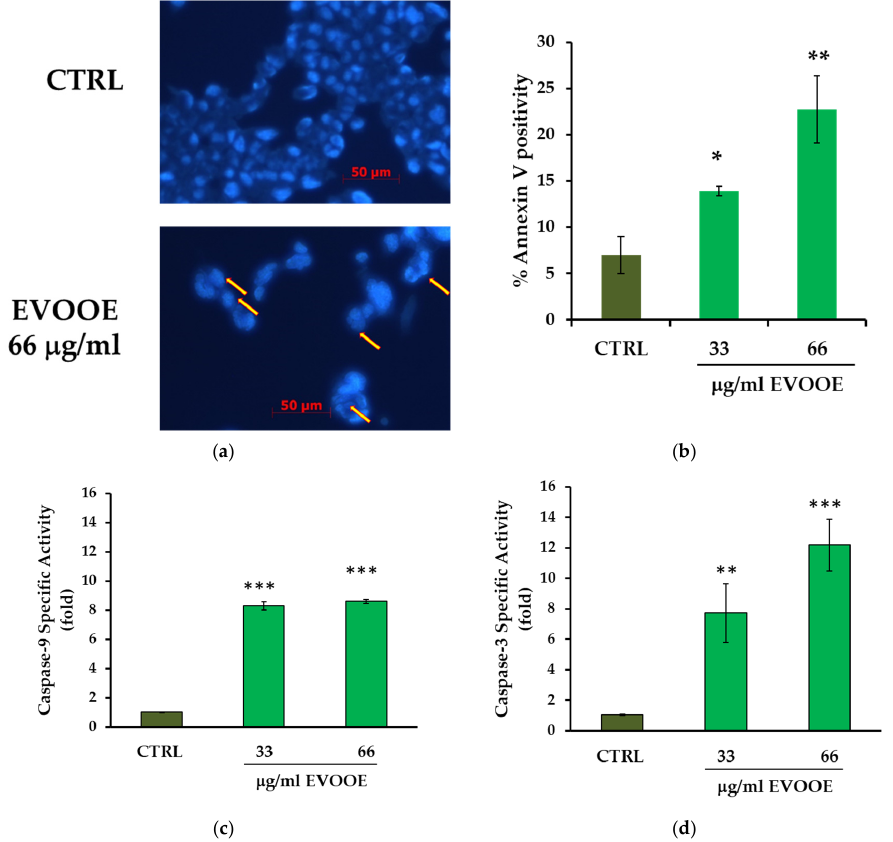
Figure 5. EVOOE stimulation induces apoptosis in J82 cells. ( a ) Representative images of nuclear staining with Hoechst dye of J82 cells untreated (top) and treated with EVOOE (bottom). Fluorescent microscopy was employed to visualize and photograph cells in a DAPI filter with 200× magnification. The arrows indicate the apoptotic bodies identified. ( b ) Annexin-V positivity to assess PS externalization was measured by cytofluorimetric analysis in cells treated for 15 h. ( c ) The proteolytic activity of caspase-9 and ( d ) caspase-3 (nmol AFC/min/mg protein) was measured after 6 h of treatment. Bar graphs represent means ± s.d. derived from three separate experiments. Symbols indicate significance: p < 0.05 (*), p < 0.005 (**), and p < 0.0001 (***) with respect to CTRL.